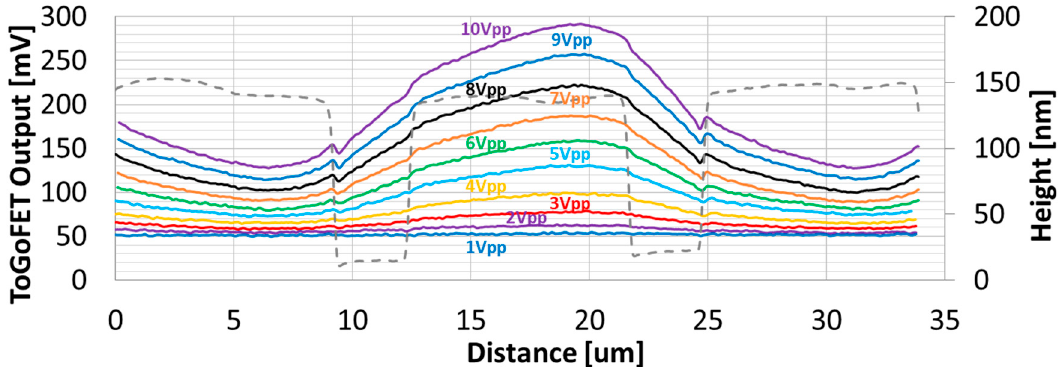
Figure 7. Line profiles of ToGoFET signals in the direction perpendicular to electrodes covered with 500-nm-thick oxide. The input voltage of each line profile is shown.